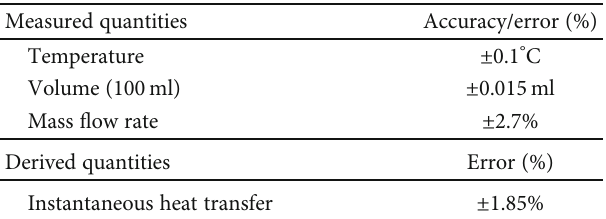
Table 2: Uncertainty in various measured/derived